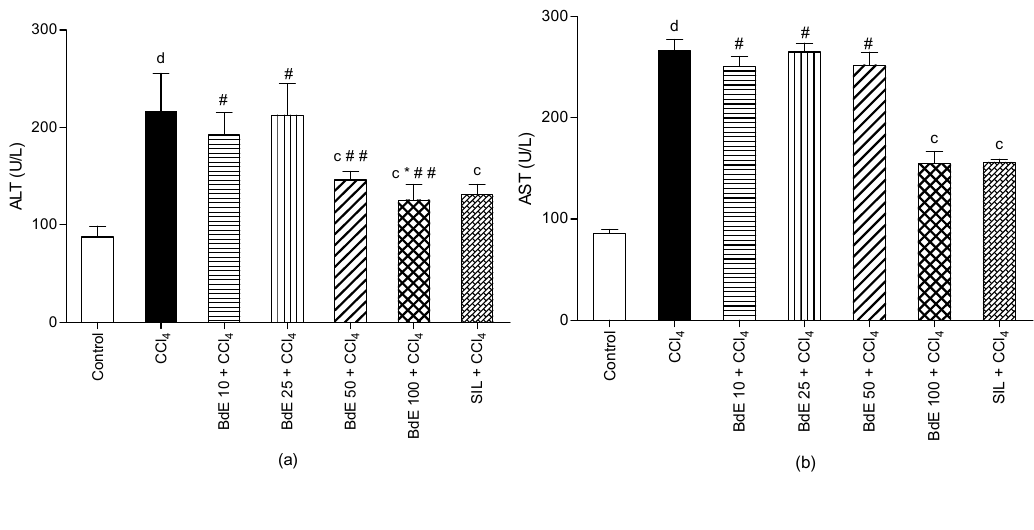
Figure 2. Effect of BdE on mice intoxicated with carbon tetrachloride (CCl liver enzymes AST ( a ), ALT ( b ) and ALP ( c